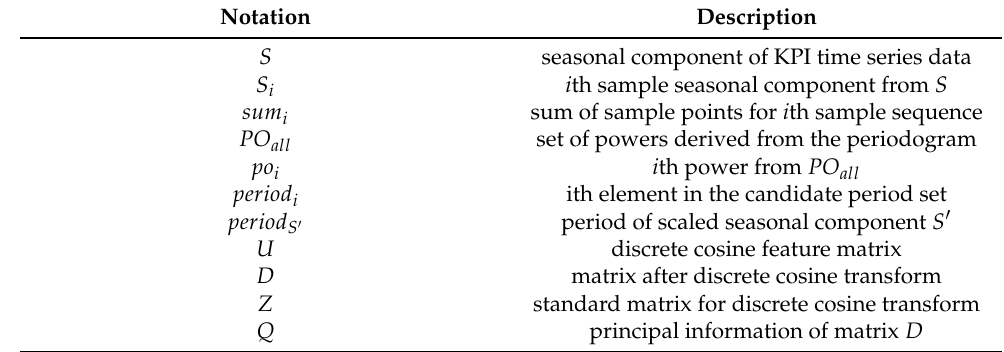
Table 2. Notations